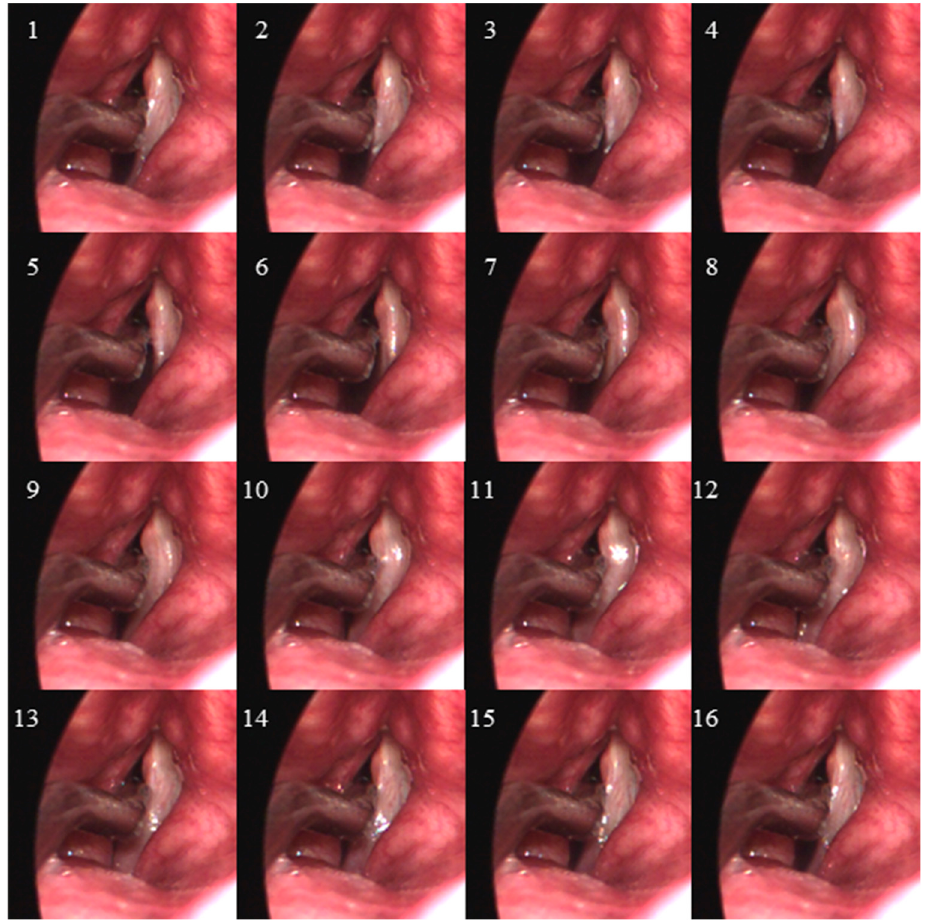
Figure 3. One phonatory cycle is displayed from the high-speed videoendoscopy data (2000 frames per second) during which the intraglottal pressure sensor of the ISP probe was deemed to be in the strike zone of the left vocal fold. Sixteen frames (frame indices indicated) are shown for the phonatory cycle that was 8 ms in duration, translating to a fundamental frequency of tissue oscillation of 125 Hz.